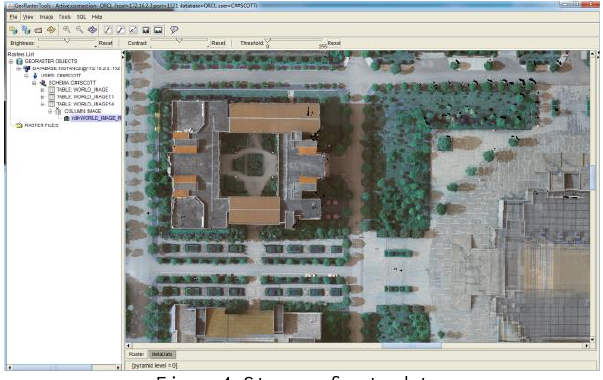
Figure 4. Storage of raster data